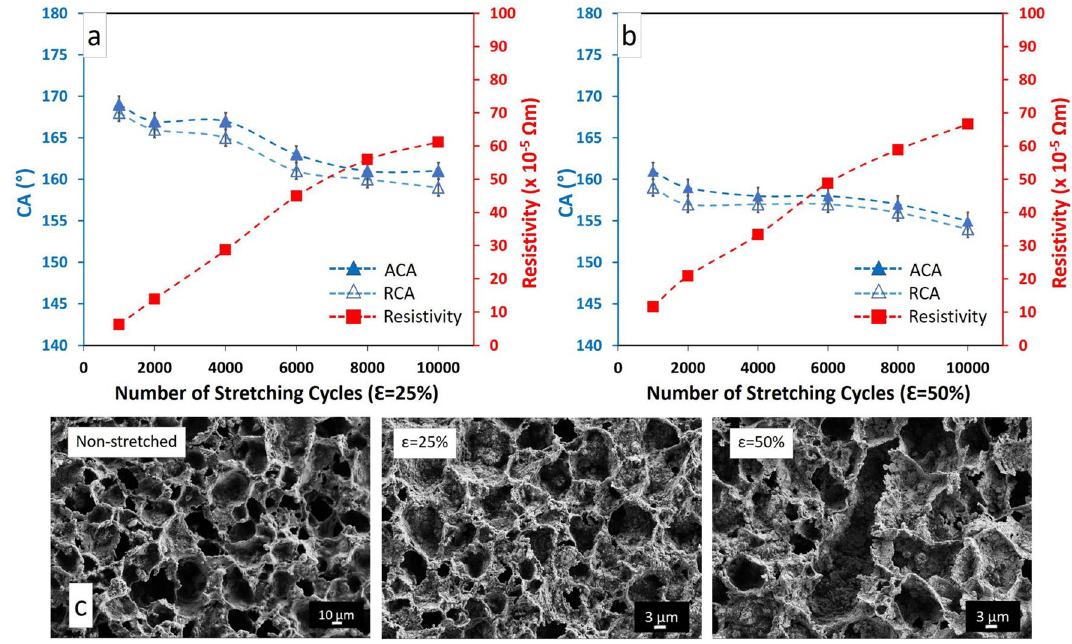
Figure 4. The contact angles and resistivity after being subjected to 10,000 stretching-relaxing cycles at ( a ) 25% and ( b ) 50% of tensile strain. ( c ) The SEM images of non-stretched and stretched samples after 10,000 stretching-relaxing cycles at 25% and 50% of tensile